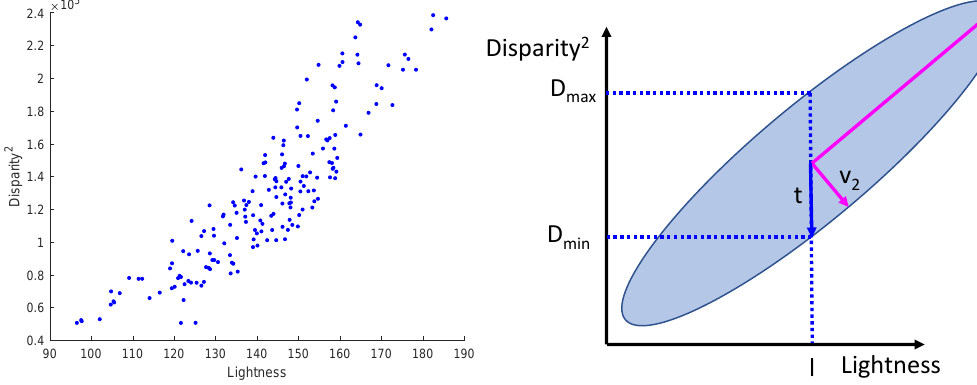
Figure 7. Disparity vs. lightness relationship for a subset of matched points. Left : local average pixel lightness vs. squared disparity. Right : an illustration of disparity tolerance, t , for a given lightness, l